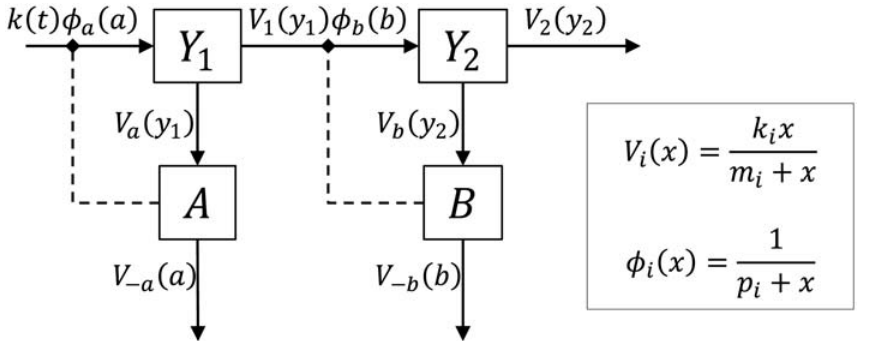
Fig 7. Interacting feedback control for perfect adaptation. A single pathway representing the concentration of two intermediates Y 1 and Y 2 , the level of each of which needs to be kept at equilibrium. This system applies two integral feedback controllers, assuming parameters m − a and m − b are small relative to concentrations a and b .